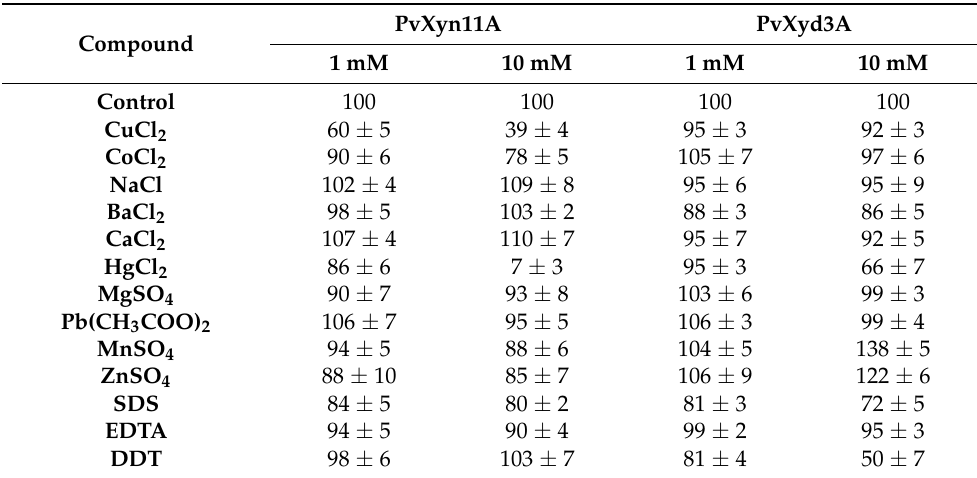
Table 2. Effect of various modulators on the relative activity (%) of PvXyn11A and PvXyd3A from B. spectabilis ATHUM